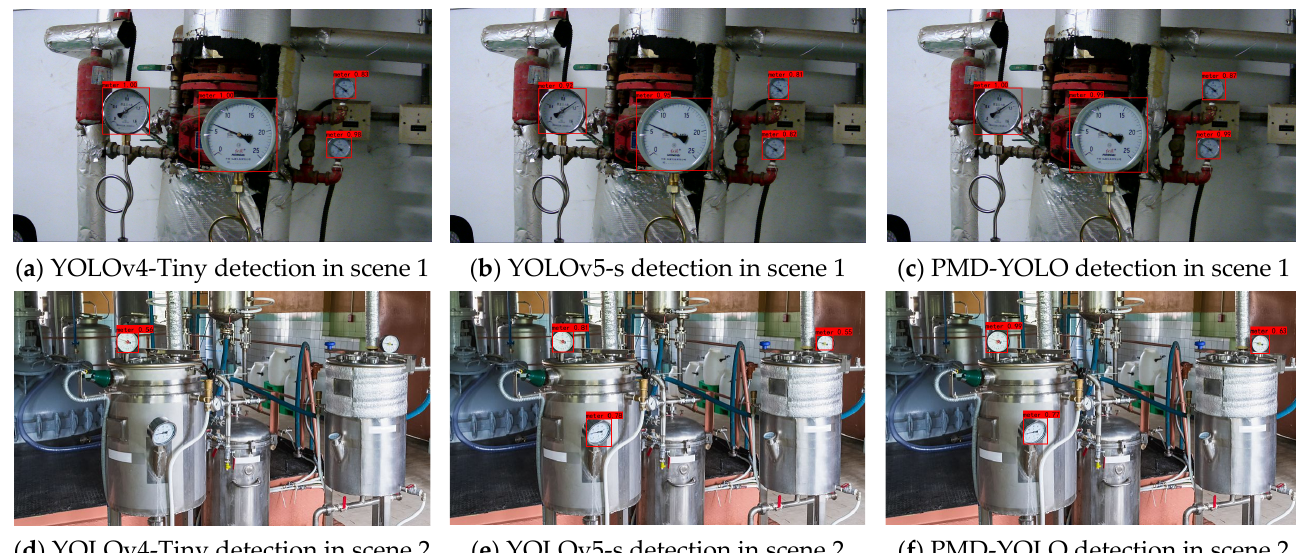
Figure 11. Comparison detection results of three models on pointer meters in different complex background scenes. The object confidence scores in each graph are shown from left to right: ( a ) shows 1.00, 1.00, 0.98, and 0.83; ( b ) shows 0.92, 0.95, 0.82, and 0.81; ( c ) shows 1.00, 0.99, 0.99, and 0.87; ( d ) shows 0.56; ( e ) shows 0.81, 0.78, and 0.55; ( f ) shows 0.99, 0.77, and 0.63.